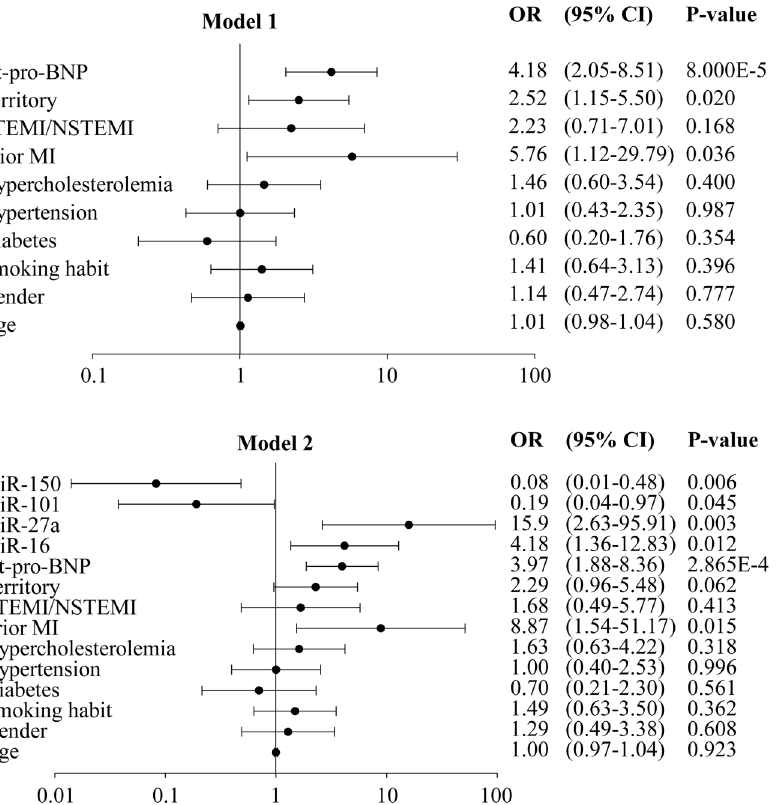
Figure 1. Odds ratios for clinical parameters, Nt-proBNP and miRNAs. Nt-proBNP and miRNAs were measured at discharge from the hospital and LV contractility was evaluated by WMIS at 6-months follow-up. Patients were dichotomized according to WMIS using a threshold value of 1.2. Patients with WMIS # 1.2 had preserved LV contractility (n=79) and patients with WMIS . 1.2 had impaired LV contractility (n=71). Logistic regression models were built to determine the increased risk of impaired LV contractility. A. Model 1 is a multivariable model including indicated clinical parameters and Nt-proBNP. B. Model 2 is a multivariable model including the variables of model 1 and the expression values of miR-16/27a/101/150. CI: confidence interval; OR: odd ratio. Note: X axis is in log scale.